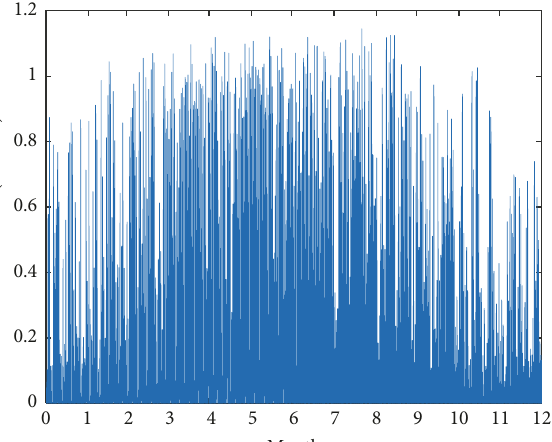
Figure 5: Wind speed.